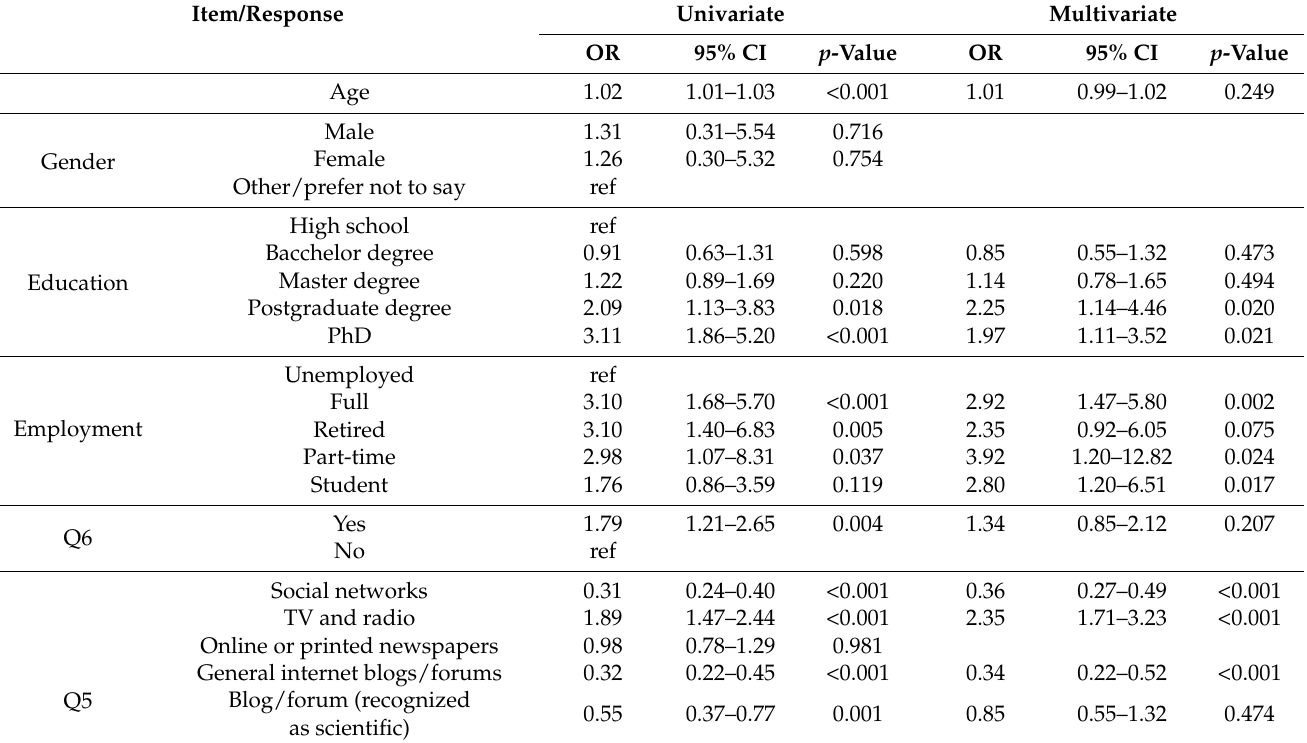
Table 2. Univariate and multivariate binary logistic regressions models examining the factors associ- ated with being